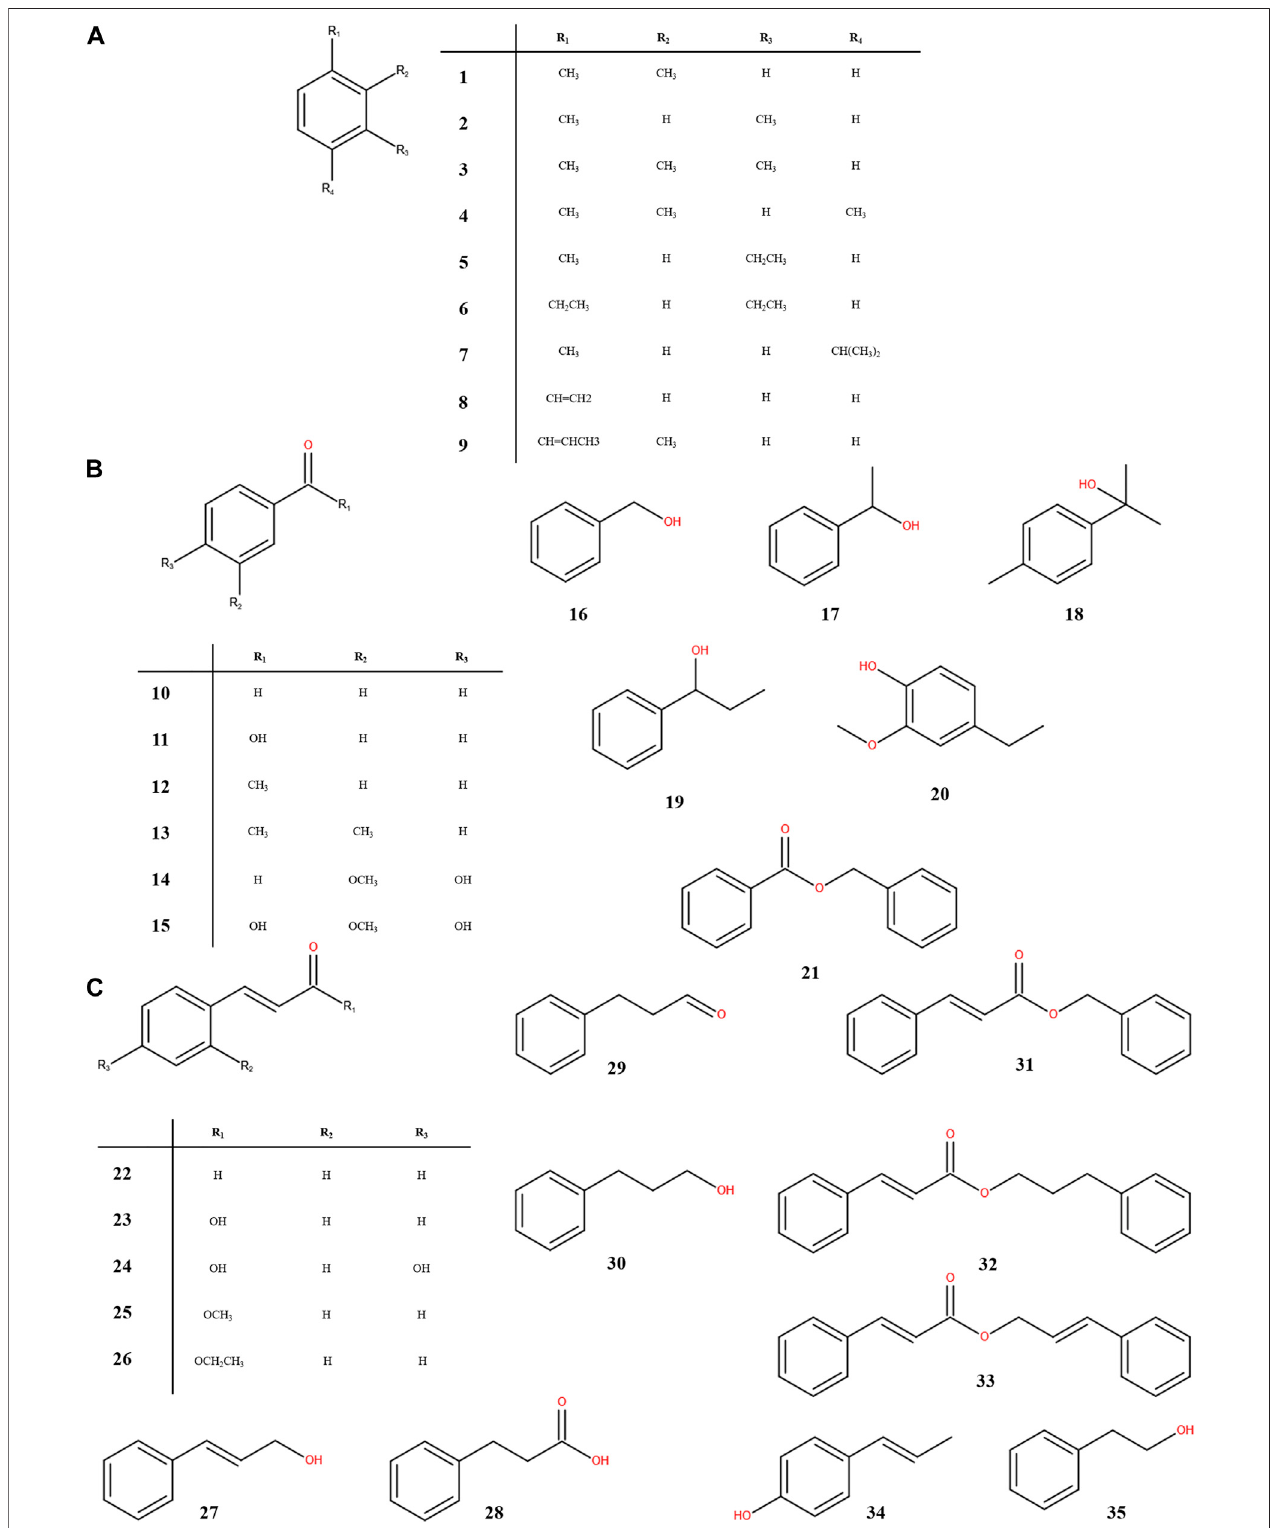
FIGURE3| Chemicalstructuresofaromaticcompoundsfromstorax.Aromatichydrocarbons (A) ;aromaticacidsandtheirderivativeswiththeskeletonofbenzoic acid (B) or cinnamic acid (C) as the core structure.